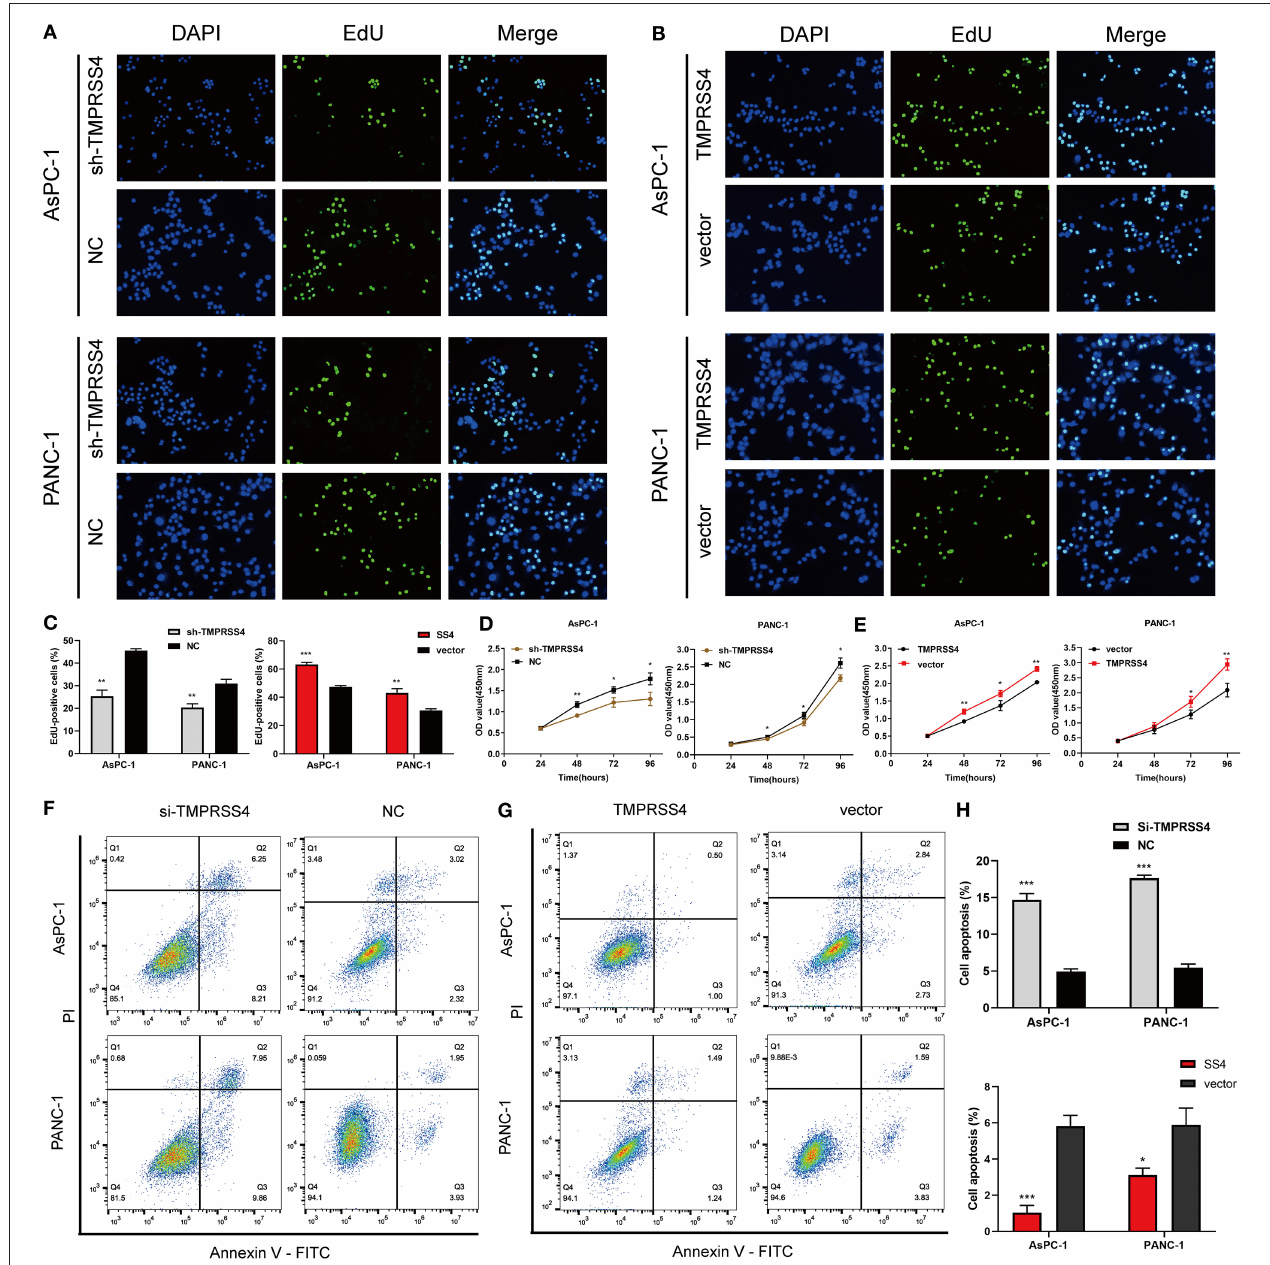
FIGURE 2 | TMPRSS4 promotes pancreatic cancer cell proliferation and inhibits apoptosis in vitro . (A–C) EdU assays (A) decreased cell proliferation in TMPRSS4 knockdown cells; (B) enhanced cell proliferation in TMPRSS4 overexpressing cells. (C) Quantification of the EdU staining of indicated cells. (D,E) CCK-8 assay on the effect of TMPRSS4 on pancreatic cancer cell growth. (F–H) Cellular apoptosis analyzed by flow cytometry. Each bar represents the mean ± SD of three independent experiments. Paired Student’s t -test was applied. * P < 0.05; ** P < 0.01; *** P < 0.001; SS4 or TMPRSS4, transmembrane protease serine 4; vector, vector-only control; shTMPRSS4, TMPRSS4 short hairpin RNA; NC, negative control; siTMPRSS4, TMPRSS4 small interfering RNA; PI, Propidium Iodide; FITC, Fluorescein Isothiocyanate.